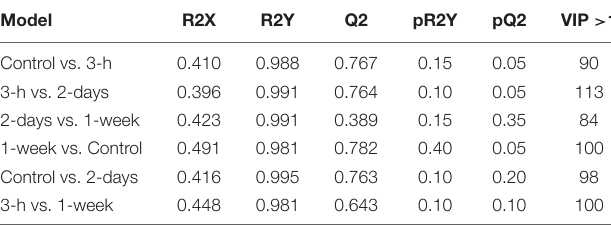
TABLE 2 | Supervised multivariate PLS-DA models computed from metabolites found in striatum metabolome differentiating two groups. Model